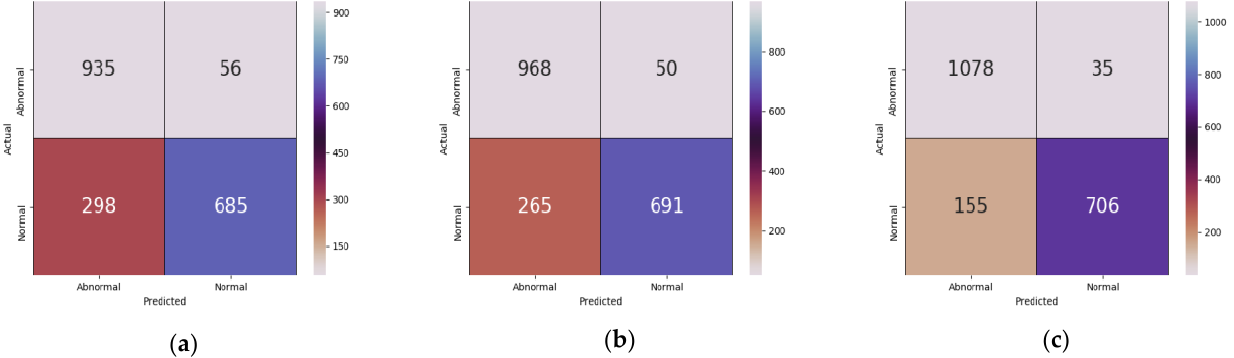
Figure 11. Confusion matrices considering public dataset [45] : ( a ) EfficientNet, ( b ) Inception-v3, and ( c ) IR-v2 Type 5.